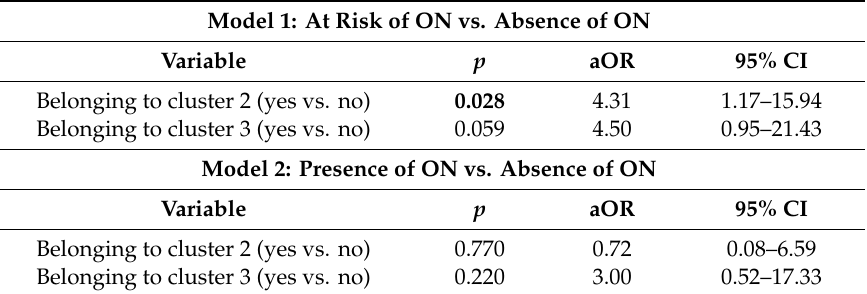
Table 8. Multivariable analysis: multinomial logistic regression taking the absence of orthorexia nervosa as the reference group. Model 1: At Risk of ON vs. Absence of ON Variable p aOR 95% CI Belonging to cluster 2 (yes vs. no) 0.028 Belonging to cluster 3 (yes vs. no) Model 2: Presence of ON vs. Absence of ON Variable p aOR 95% CI Belonging to cluster 2 (yes vs. no)